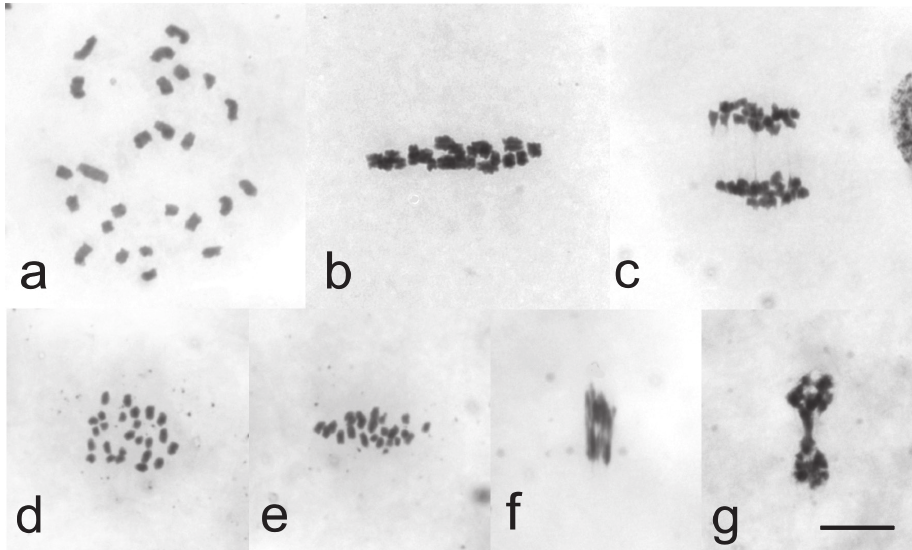
Figure 2. Male meiosis without chiasmata in C. myrtilli ( a ) Diakinesis with 25 univalent chromosomes ( b ) Metaphase I in side view with 25 bi-oriented univalents ( c ) Anaphase I, daughter chromosomes mov- ing towards opposite poles. No laggard chromosomes present ( d ) Metaphase II in polar view showing 25 daughter chromosomes ( e ) Metaphase II in side view. All bi-oriented daughter chromosomes aligned with the equatorial plane ( f ) Anaphase II, daughter chromosomes stretched towards poles ( g ) Telophase II, daughter nuclei joined by stretched chromosomes. Bar equals 10